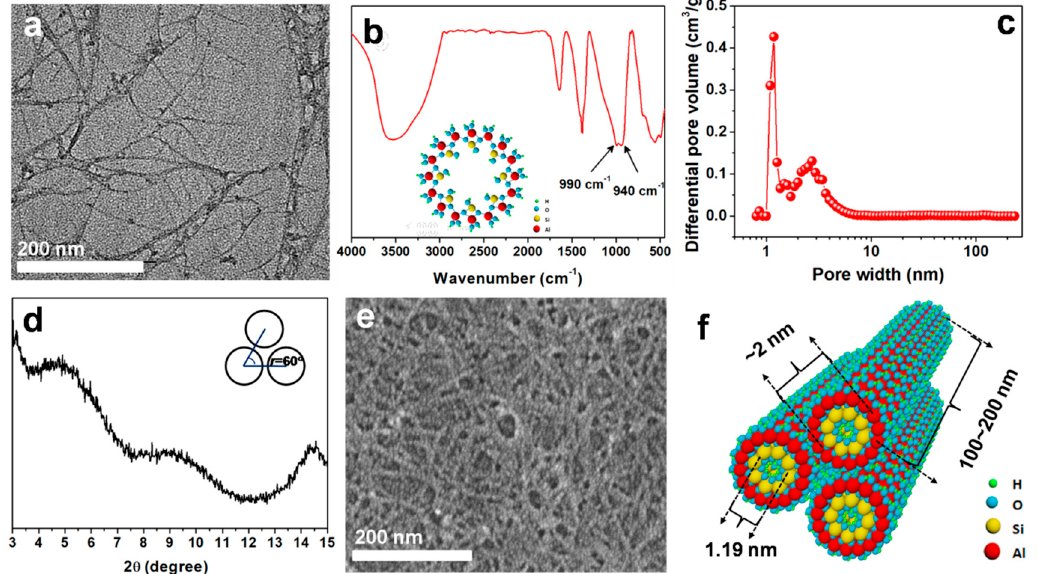
Figure 1. Characterization of synthesized aluminosilicate nanotubes (ANTs): ( a ) TEM image, ( b ) FTIR spectrum, ( c ) BET curve, ( d ) XRD pattern, ( e ) FESEM image, and ( f ) schematic illustration of ANTs. Insert in (b) is the atom structure of ANTs viewed along the axial direction.